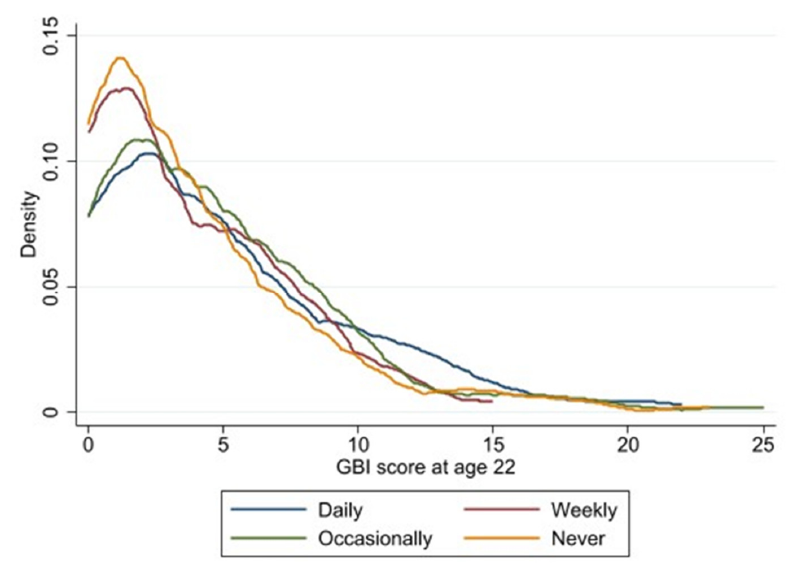
Figure 1. Distribution of the GBI score at age 22 by sex.